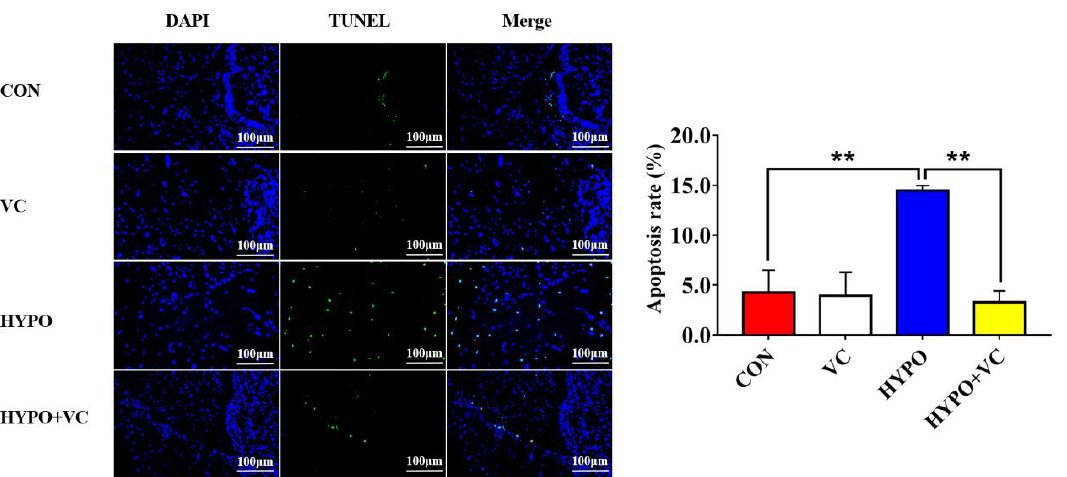
Figure 9. Changes of DAPI and TUNEL staining from representative sections in the hypothalamus of gibel carp in the normal group and hypoxia group after 56 days of feeding with VC. Positive apoptotic nuclei in green and normal nuclei are shown in blue. The magnification and scale of the microscope were 200× and 100 μm, respectively. The ** at the top of the bar chart indicates significant differences between treatments; ** indicates an extremely significant difference ( p < 0.01). All of the data are presented as the mean ± standard error (n = 6).